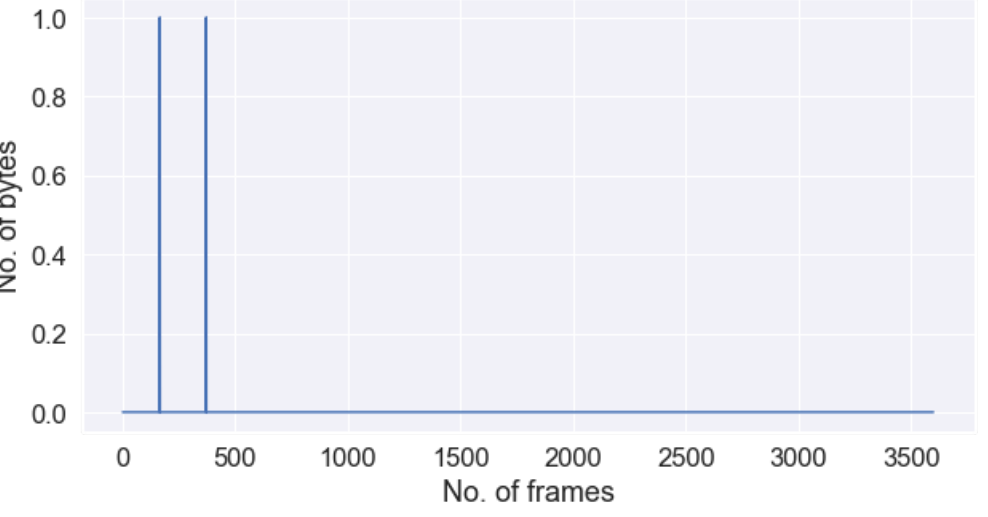
Figure 28a. I/O read requests